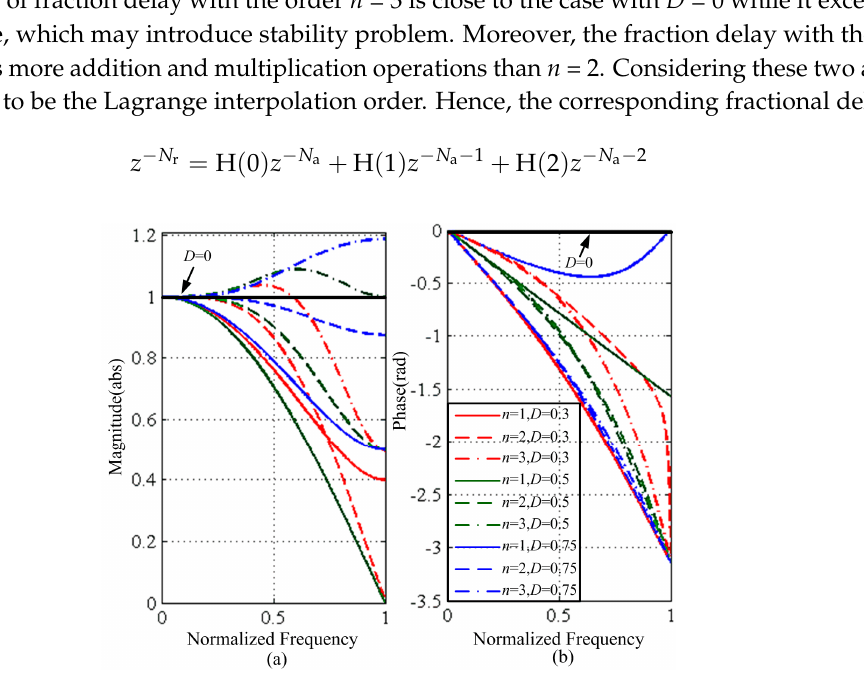
Figure 4. Frequency responses of Lagrange-interpolating fraction delay. ( a ) Magnitude responses; ( b ) Phase responses.